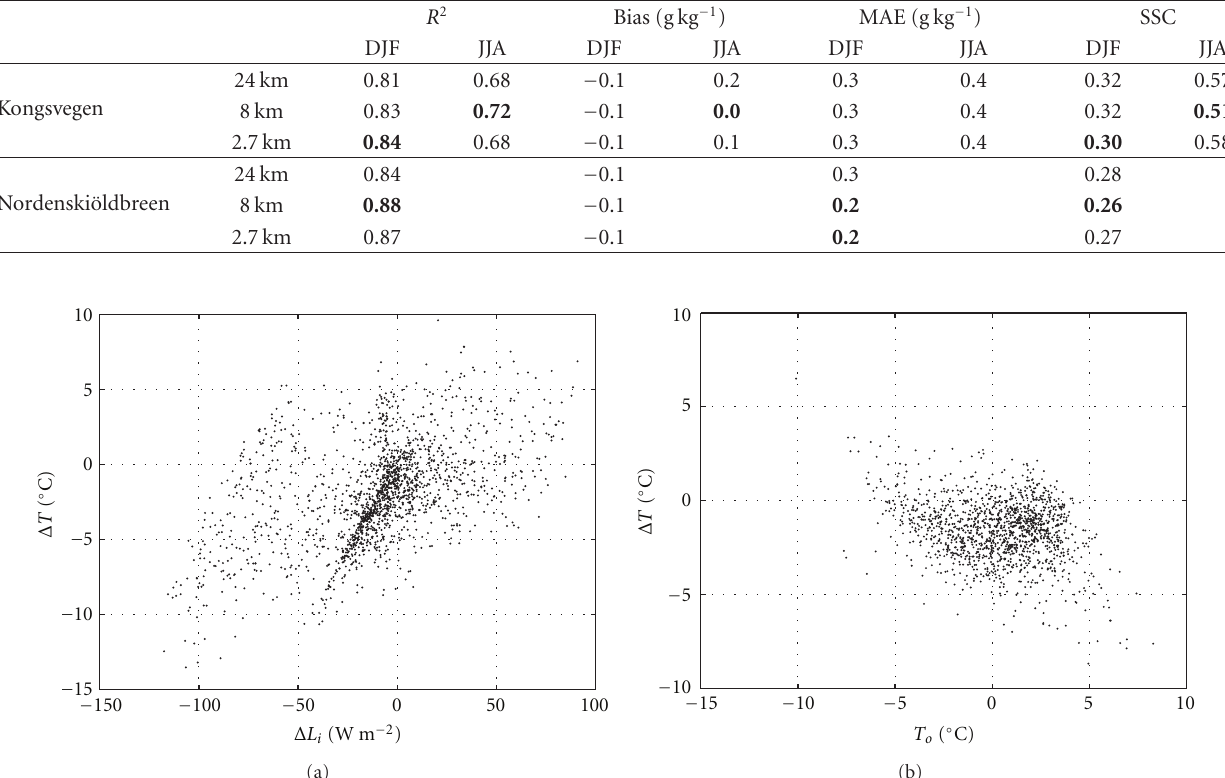
Figure 3: Temperature error (model observation) at Kongsvegen for 8km resolution and as function of, in (a) error in incoming long-wave radiation (model observation) and (b) the observed